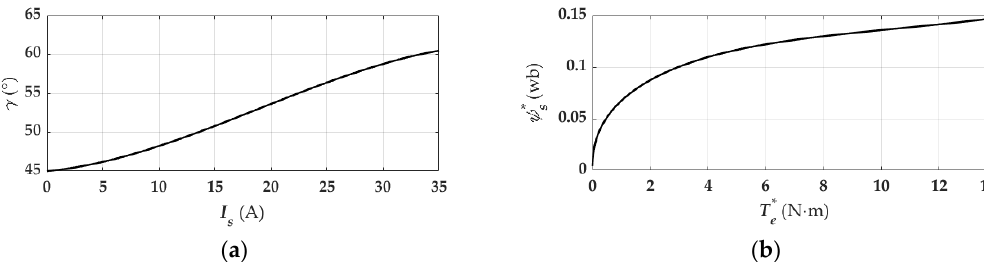
Figure 4. The MTPA trajectories that were calculated by considering the nonlinear characteristics: ( a ) current–angle trajectory and ( b ) torque–flux linkage trajectory.